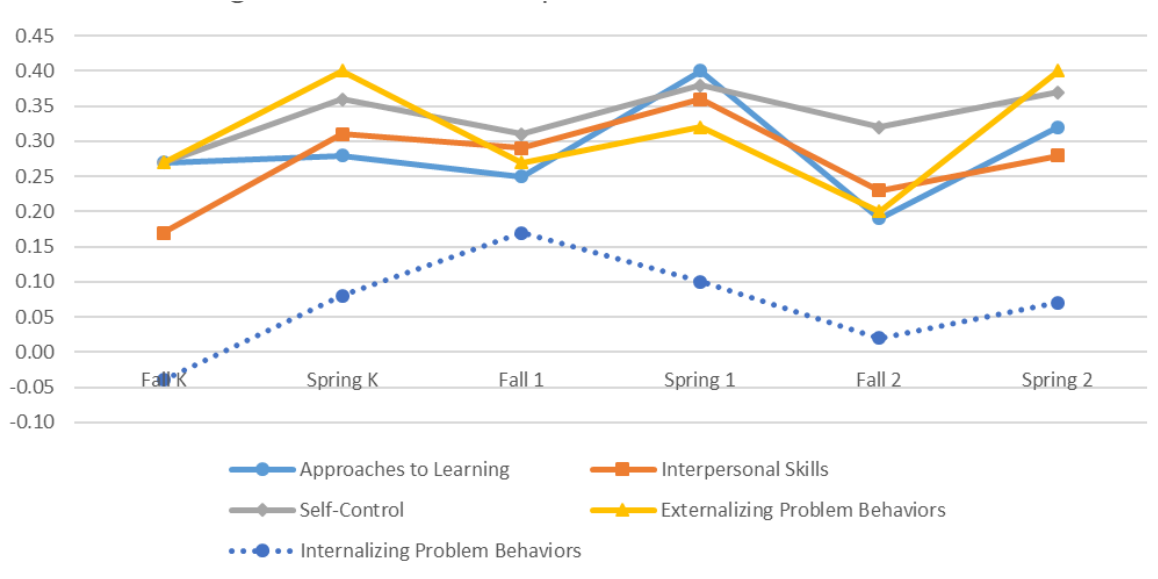
Figure 3: White-black gap in social and behavioral